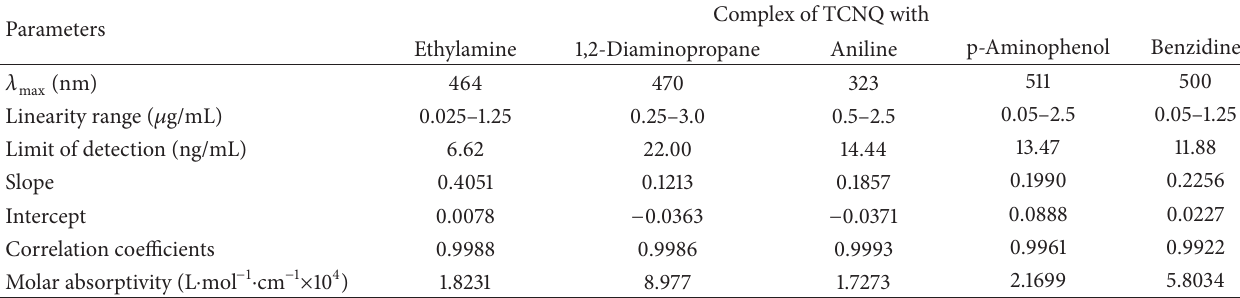
Table 4: Summary of optical characteristics and statistics for the proposed